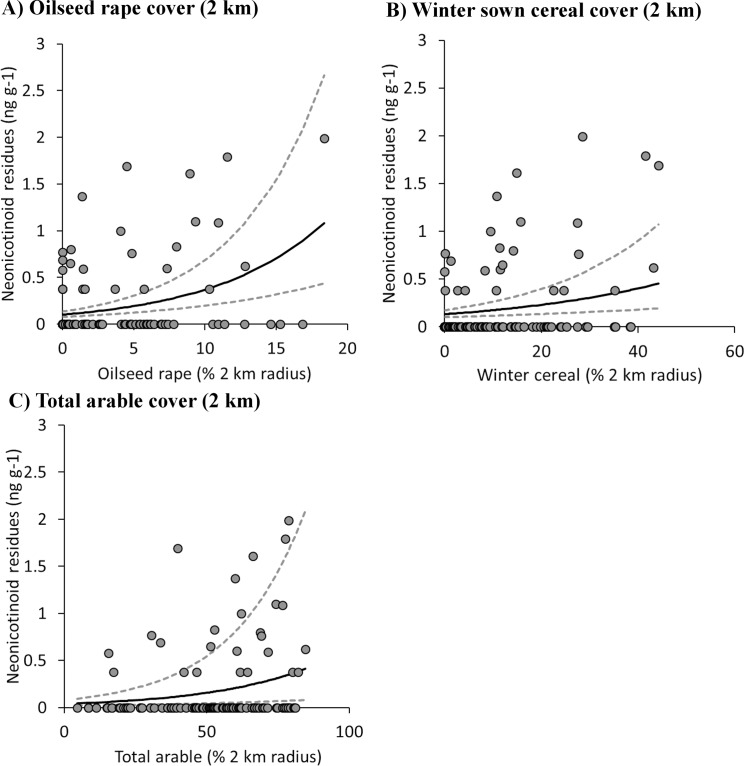
Response of combined neonicotinoid residues in honey to land use.The graphs show the back transformed model predictions (±SE) for the response of combined neonicotinoid residues found in honey to (A) oilseed rape cover, (B) winter sown cereals and (C) total arable cover. All honey was collected in 2015 during the first year where the use of neonicotinoids seed treatments had been banned on mass flowering crop in the EU. All percentage covers are within 2 km radii of individual hives. Neonicotinoid residues represent the combined concentration of imidacloprid, thiamethoxam and clothianidin.